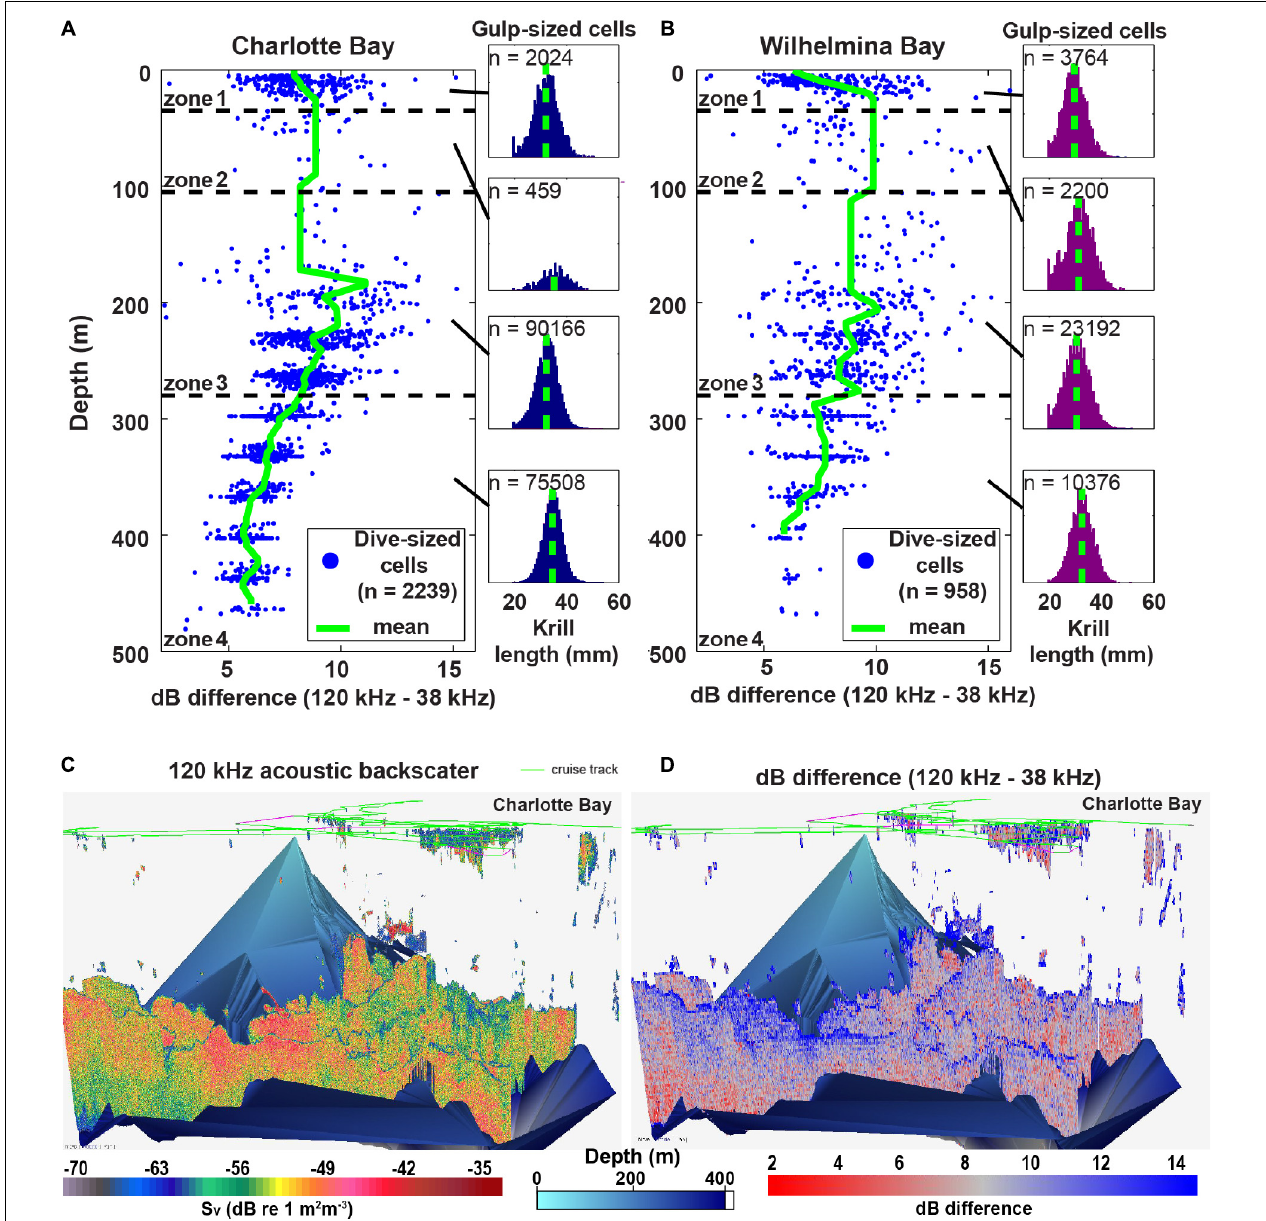
FIGURE 8 | Mean krill size changes with depth. (A) Charlotte Bay dB differencing in dive-sized cells (left) and the distribution of krill lengths predicted from the dB differences of gulp-sized cells (right) in each depth zone. Note that the relationship of krill size to depth was similar for gulp-sized cells and dive-sized cells, but dive-sized cells are presented here for clarity of the graph. (B) Same as panel (A) but for Wilhelmina Bay. Note that the mean in zone 1 (29.6 ± 4.4 mm) is similar to the measured length of krill collected at the surface (28.0 ± 3.8 mm). (C) Acoustic backscatter (a proxy for biomass) in the surveyed region of Charlotte Bay. Bottom data interpolated from the sounder-detected bottom. (D) 120 –38 kHz dB differencing (of each gulp-sized cell) in Charlotte Bay. Red values (small dB difference) imply larger krill.